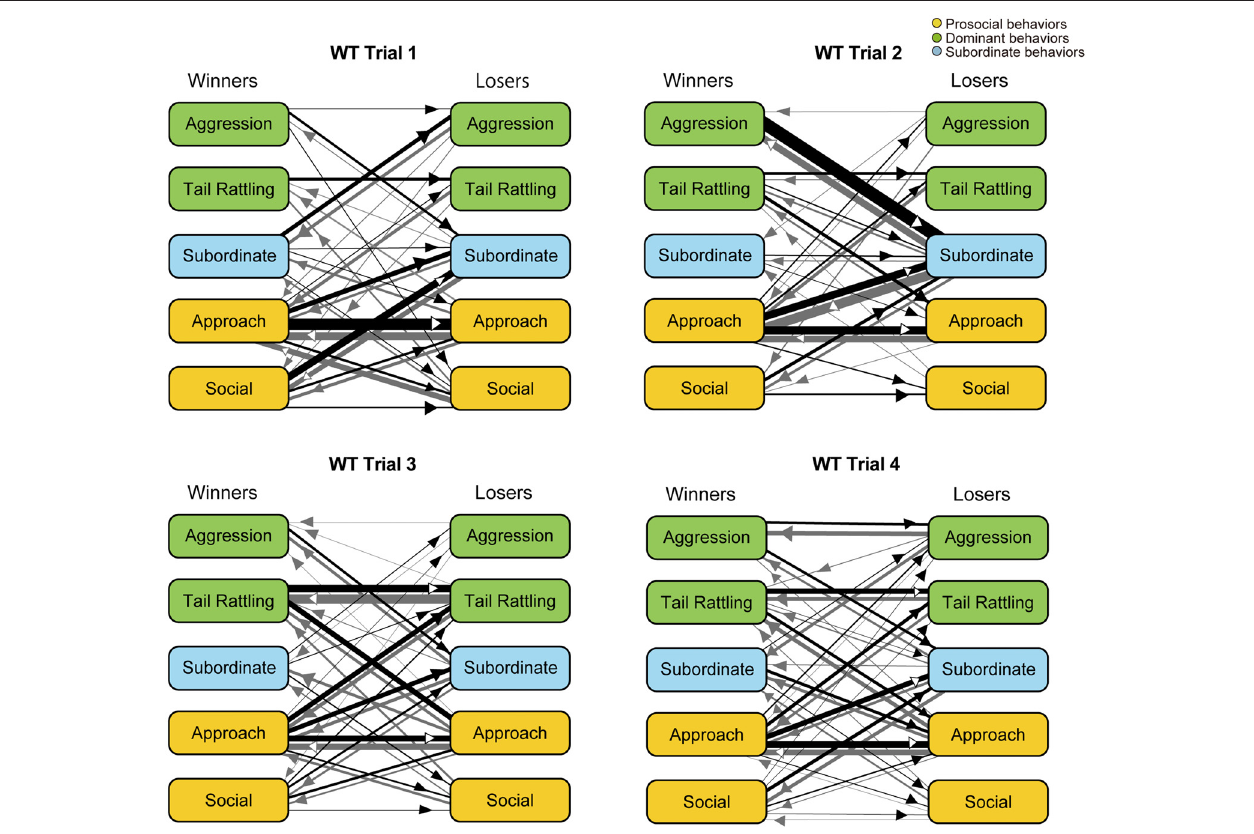
FIGURE 5 | Kinetograms for dyad behavioral transitions of WT pairs in each trial. Width of the arrows were also calculated using the following formula. Arrow width is proportional to (Total number of each transition)/(Total number of all transition within each genotype, trial and initiator). Black arrows indicate dyad transitions initiated by the winners. Gray arrows indicate dyad transitions initiated by the